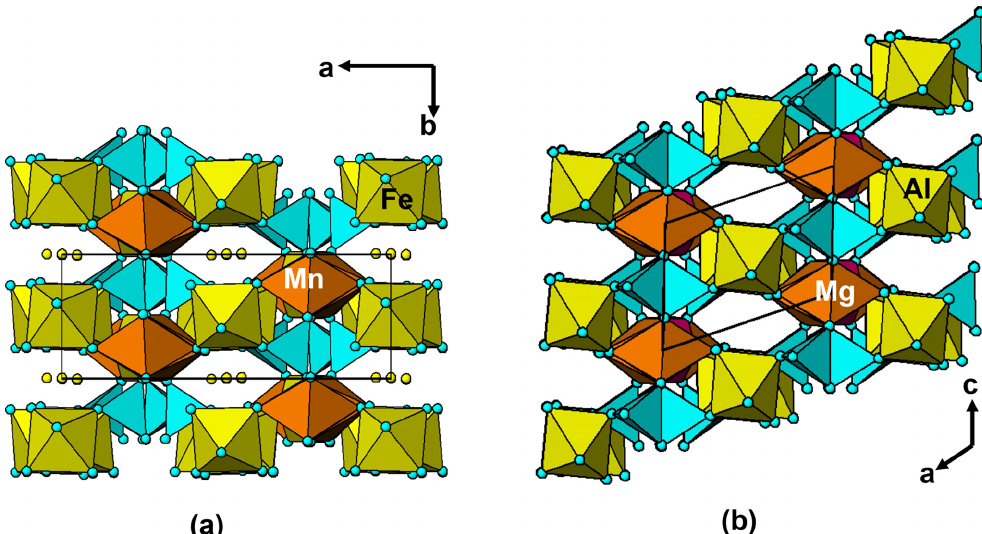
Figure 6. Common projections of the crystal structures of (a) kenngottite and (b) souzalite, showing the different relative locations of the corner-connected octahedral trimers (yellow octahedra) in successive (100) planes in the two structures.